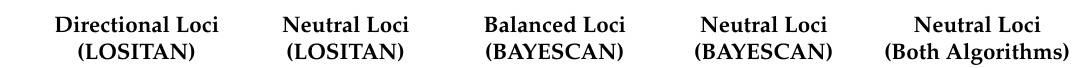
Table 2. Global molecular variation of microsatellite polymorphisms between the Atlantic and the Mediterranean hake populations, i.e., basins ( F CT = 0.026 *) and among five regions ( F SC = 0.020 *) as broken down per loci of subsets classified per selective type (directional, balanced,